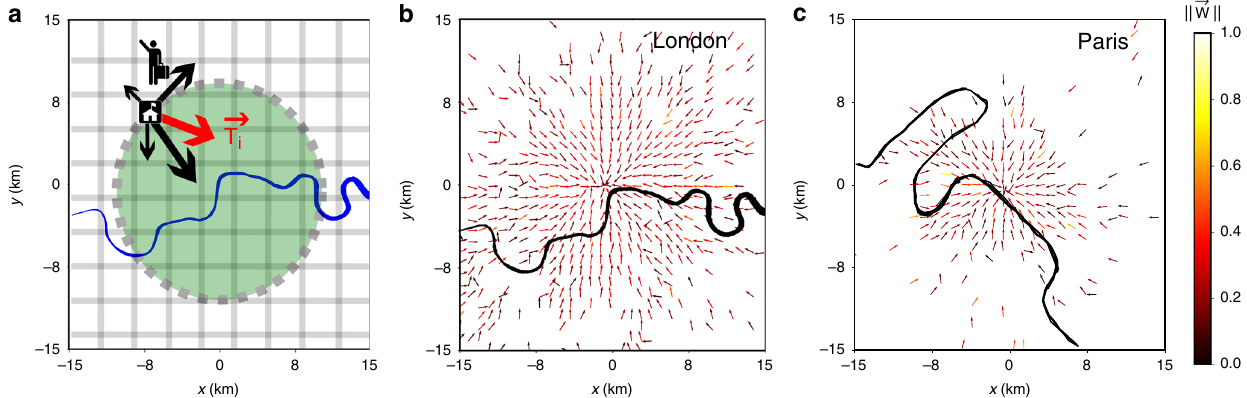
Fig. 1 Empirical vector fi elds. a Sketch of the method to build the vector fi eld. Each fl ow from cell i to j is a vector centered in i , with direction pointing to j and whose modulus is equal to T ij . Summing vectorially these vectors, we obtain T Commuters vector fi eld W for the London ( b ) and Paris ( c ) areas. Colors represent the module of the fi eld jj W